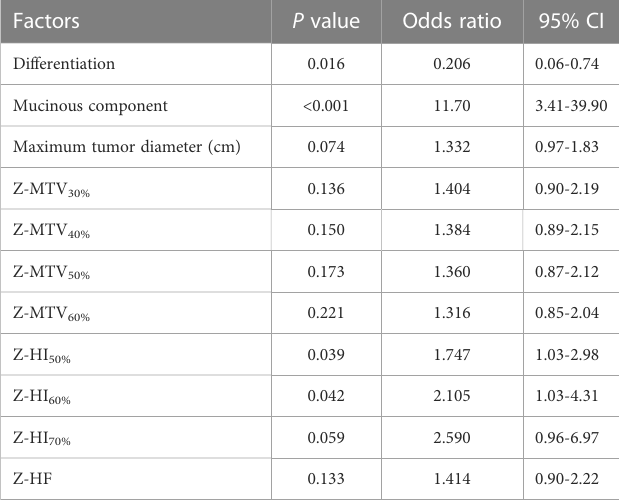
TABLE 2 Univariate regression analyses for predicting MSI in CRC patients. Factors P value Odds ratio Differentiation